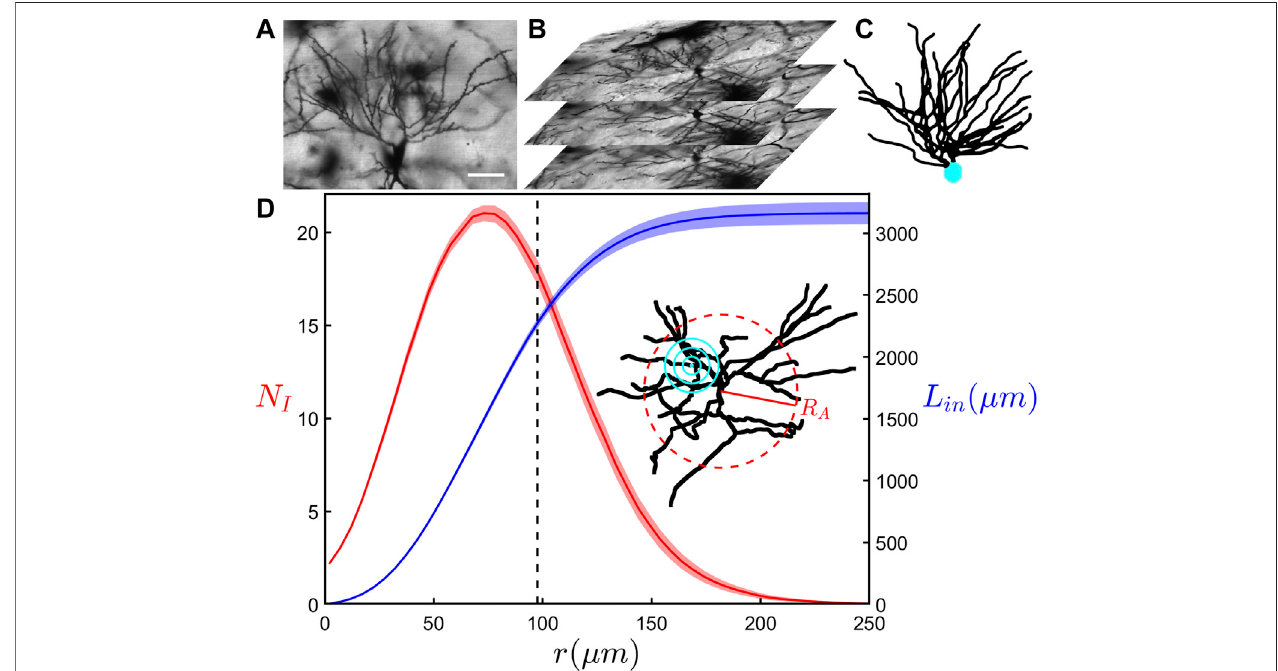
FIGURE1|(A) Aconfocalmicroscopyimageinthex-yplaneshowingthebasalportionofaneuron.Thescalebarcorrespondsto50 μ m. (B) Az-stackofconfocal microscopyimagesthatareusedinthereconstructionoftheneurons. (C) Acompleted3-dimensionalreconstructionofaneuronwithitsbasalarborinblackandsomain cyan. (D) Theresults ofamodi fi edShollanalysis(red) measuring theaveragenumberofintersections ofdendrites, N I ,withaspheresurfaceofradius r ,and acumulative length analysis (blue) measuring the total length of all dendrites, L in , within a sphere of the same radius. These curves represent the mean behavior across all basal arbors within the SH-ENR-TR group and the shaded region around each curve shows the standard error from the mean. The inset shows an example neuron ’ s basal arborwithitsarborradius,